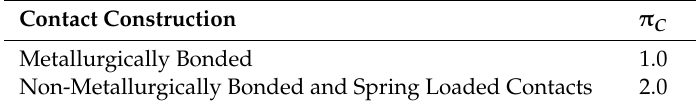
Table 2. Two values of contact construction factor based on different conditions [47,67].